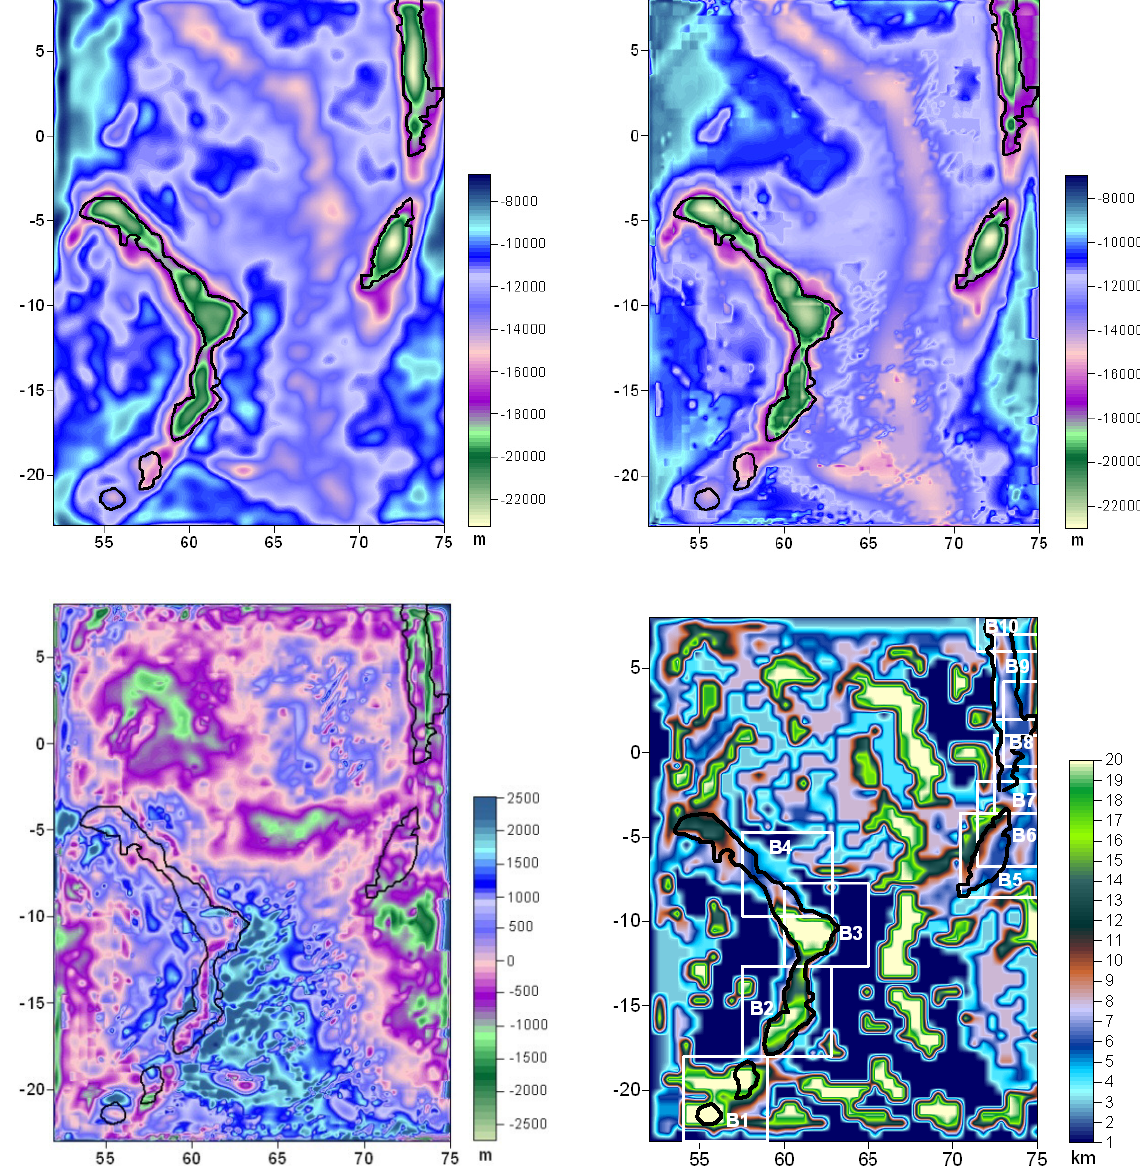
Figure 4. Moho depth and elastic thickness. (a) Moho depth from the constrained gravity inversion. (b) Moho depth from the flexural inversion. (c) Residual Moho (gravity-inversion-derived Moho - flexural-inversion-derived Moho). (d) Spatial variation of the effective elastic thickness. The white squares in (d) show the blocks used by Tiwari et al. [2007] to compute the Te by the free-air admittance